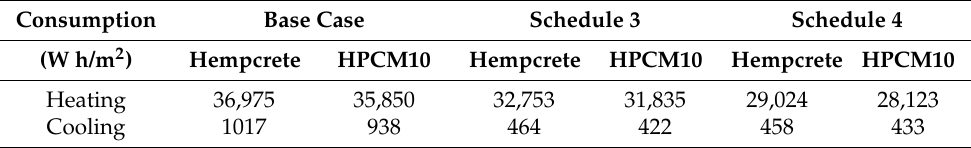
Table 5. Annual energy consumption under BC, SCH3, and SCH4.